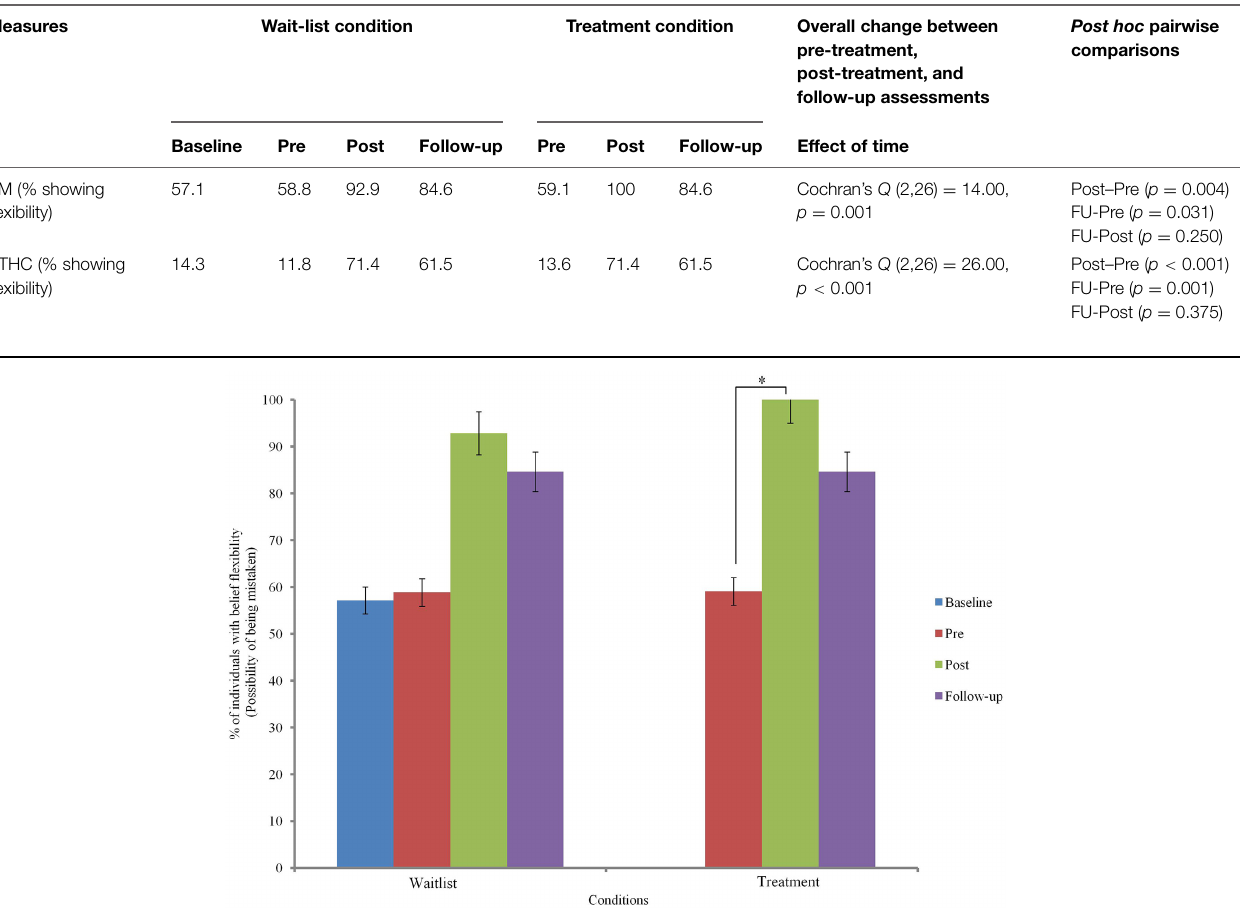
TABLE 5 | Comparisons of belief flexibility across time points.